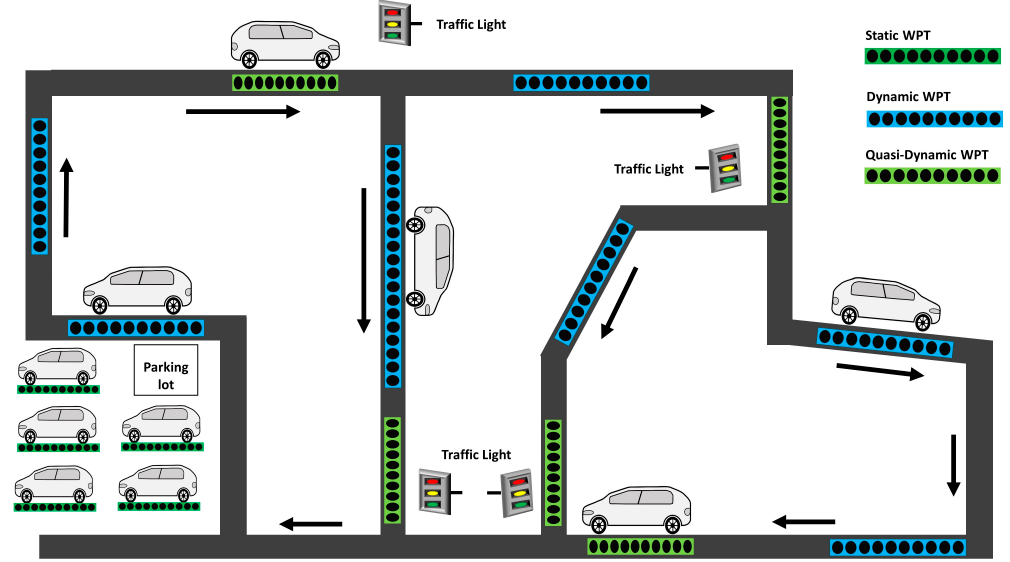
Figure 14. Conceptual demonstration of installation of SWC, DWC, and QWC [7].